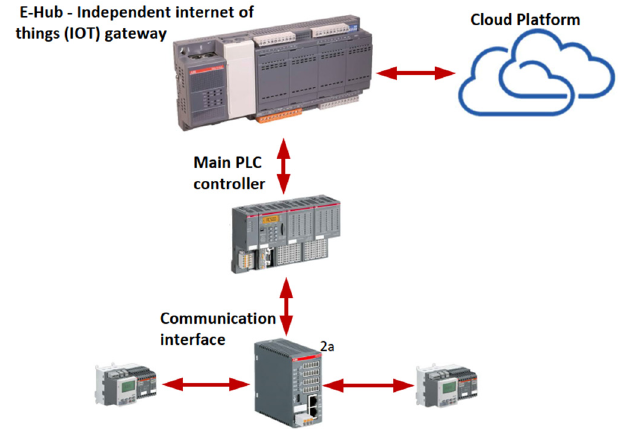
Figure 11. Cloud data acquisition solutions.